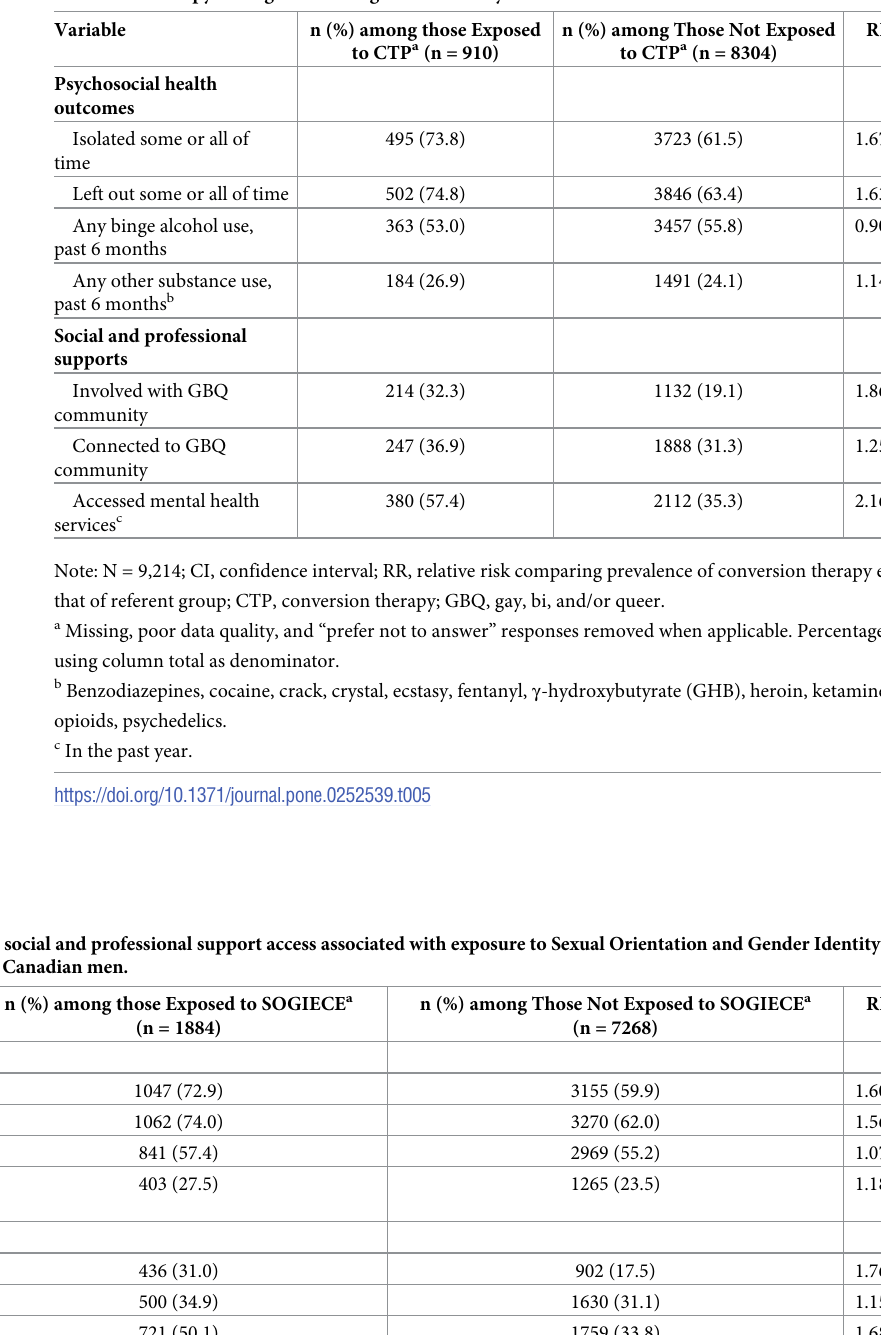
Table 5. Psychosocial health outcomes and social and professional support access associated with exposure to conversion therapy among sexual and gender minority Canadian men.